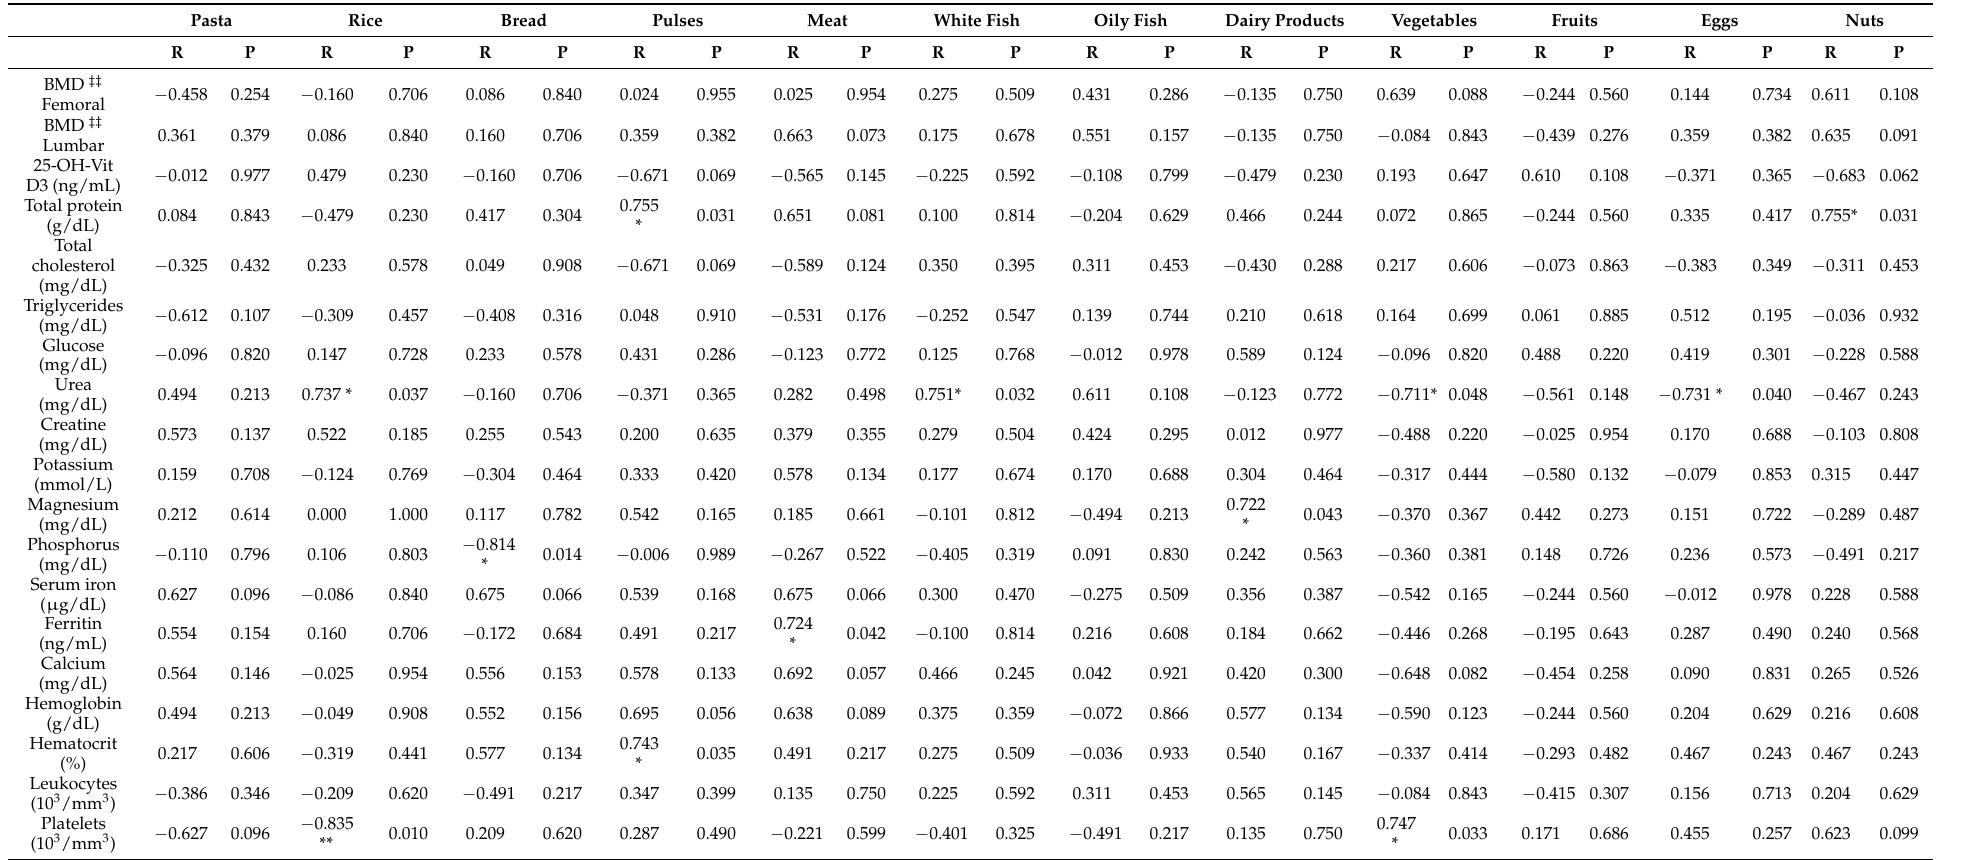
Table 5. Correlations ‡ of analytical and biochemical values with frequency of food